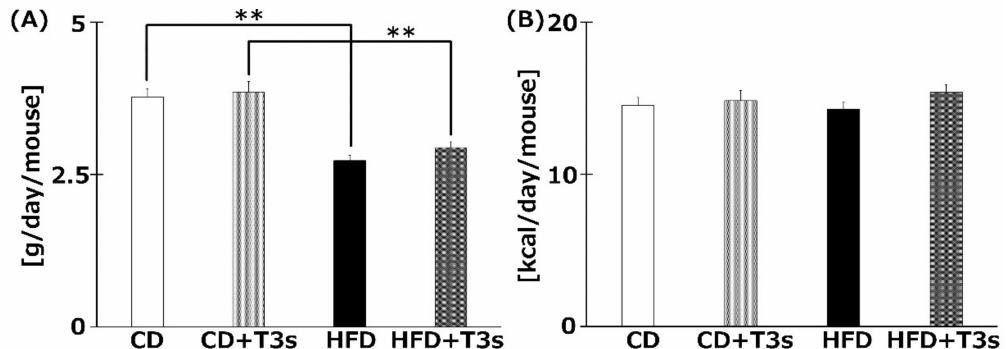
Figure 3. The average food ( A ) and calorie ( B ) intake of each group. Food intake was measured once per week. Calorie intake was calculated from food intake. CD = Control diet ( n = 10), CD + T3s = CD + T3 mix ( n = 10), HFD = high-fat diet ( n = 10), HFD + T3s = HFD + T3 mix ( n = 10). Data are expressed as mean ± SE. Tukey–Kramer’s method: ** p <